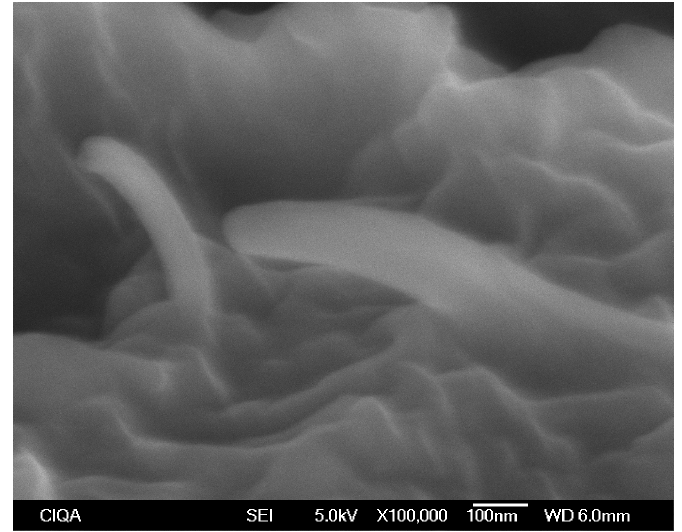
Figure 4. SEM micrographs for ABA film containing 1.0 wt % MWCNT in the A-layers fabricated using masterbatch with MFI = 34 g/10 min with ultrasound-assist method V-U.